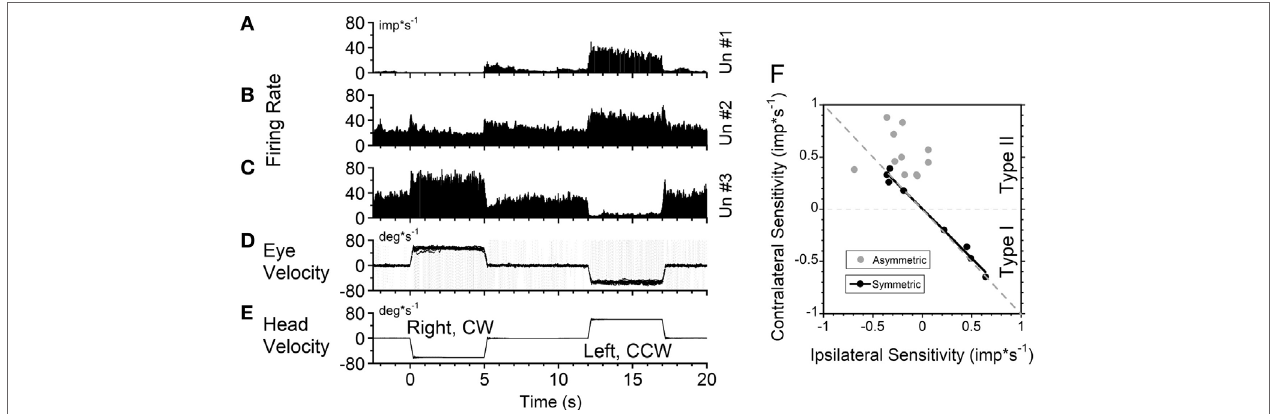
FigUre 4 | Changes in neuronal firing rate of three vestibular-only neurons located in the left (a) and right (B,c) hemispheres in response to head rotation to the right [ (e) , negative velocity] and to the left (positive velocity) in darkness. (D) Superimposed eye velocities for 10 repeated rotations. Gray—original eye velocities. Black—slow phase eye velocities. See details in the text. (F) Relationship between average sensitivity to rotation toward ipsilateral (abscissa) and contralateral (ordinate) sides. Black symbols—neurons with identical sensitivities to rotation in both directions ( p < 0.05). Gray symbols—neurons with asymmetrical